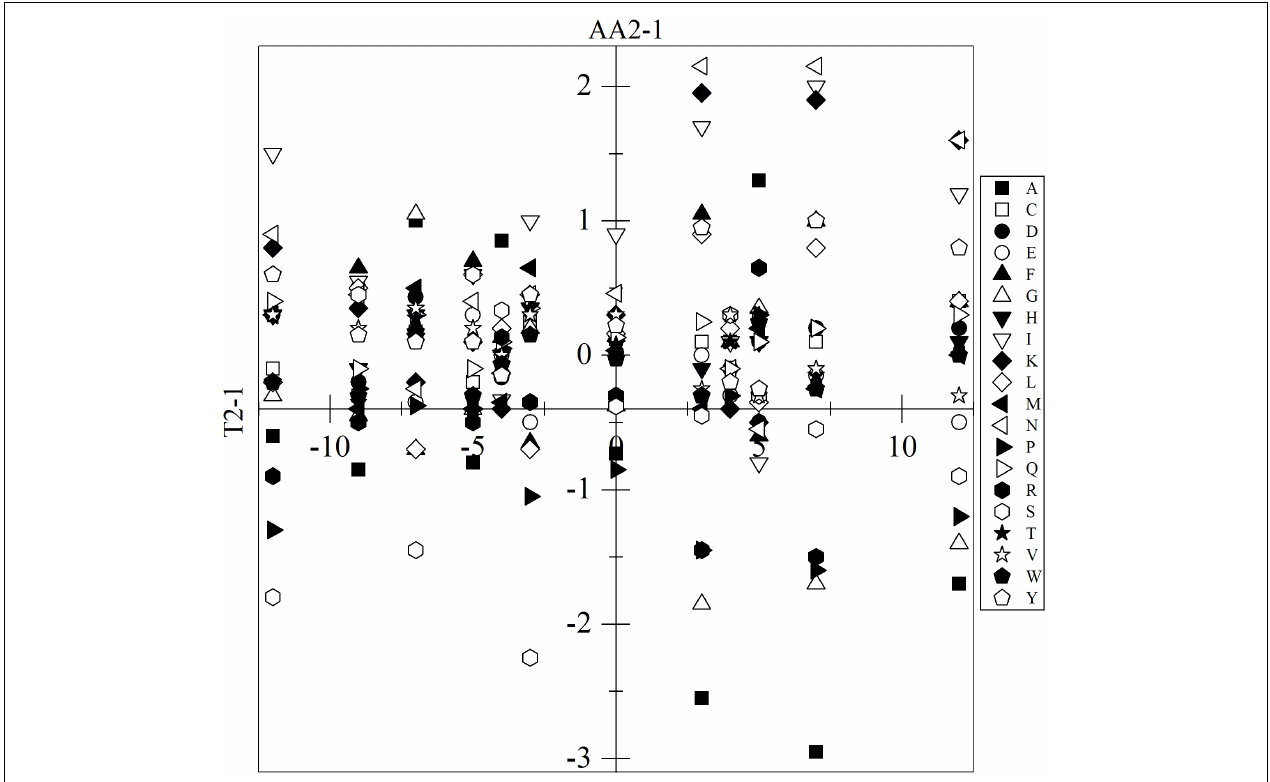
FIGURE 2 | Variation among yeasts of their optimal temperature for growth and amino acid content. The difference among yeasts in optimal temperature for growth (T2-1) was plotted vs. their difference in the amino acid content (AA2-1). Only the results with significant differences are shown (ANOVA-Tukey, p <